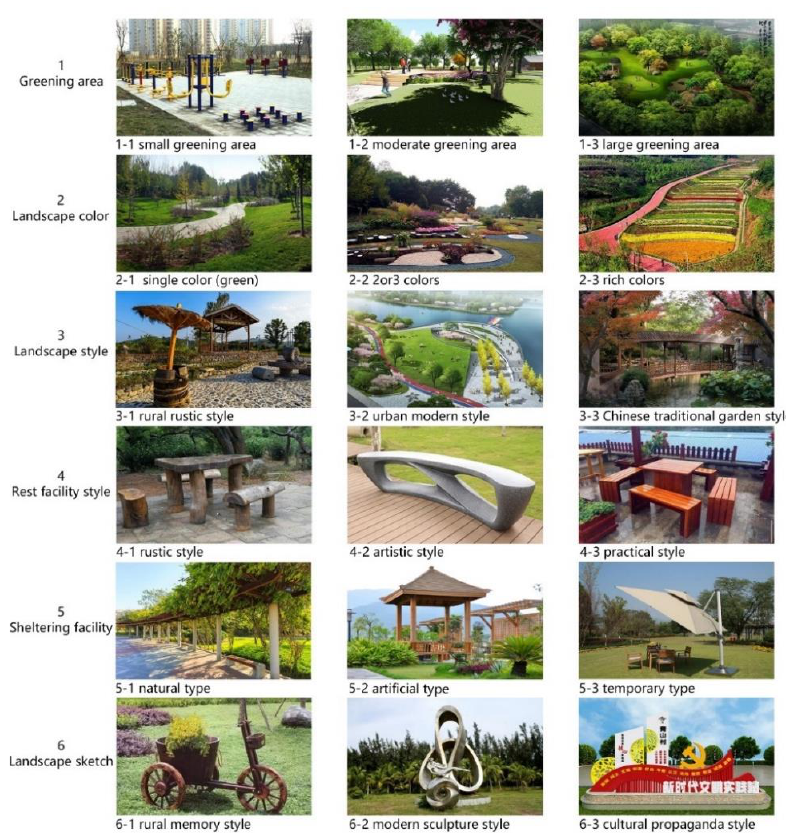
Figure A1. Images used in the questionnaire to illustrate the options to the villagers.